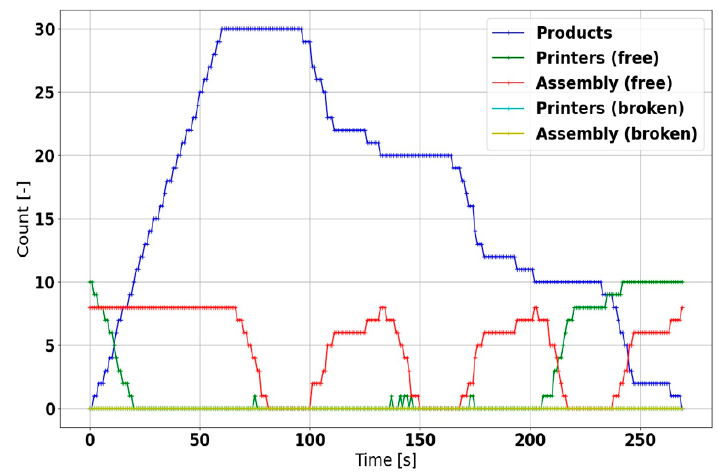
Figure 16. The regular discrete event simulation scenario.